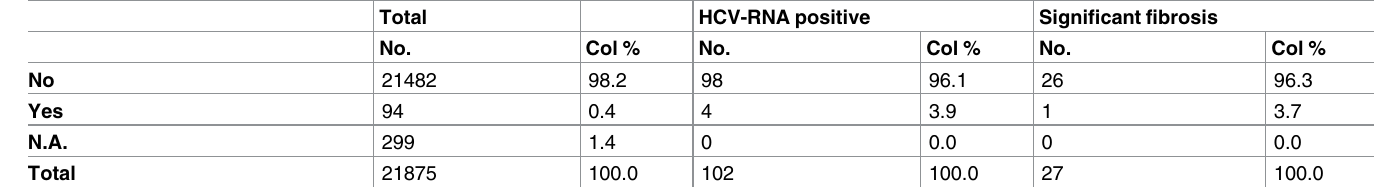
PLOS ONE | https://doi.org/10.1371/journal.pone.0185055 September 20,